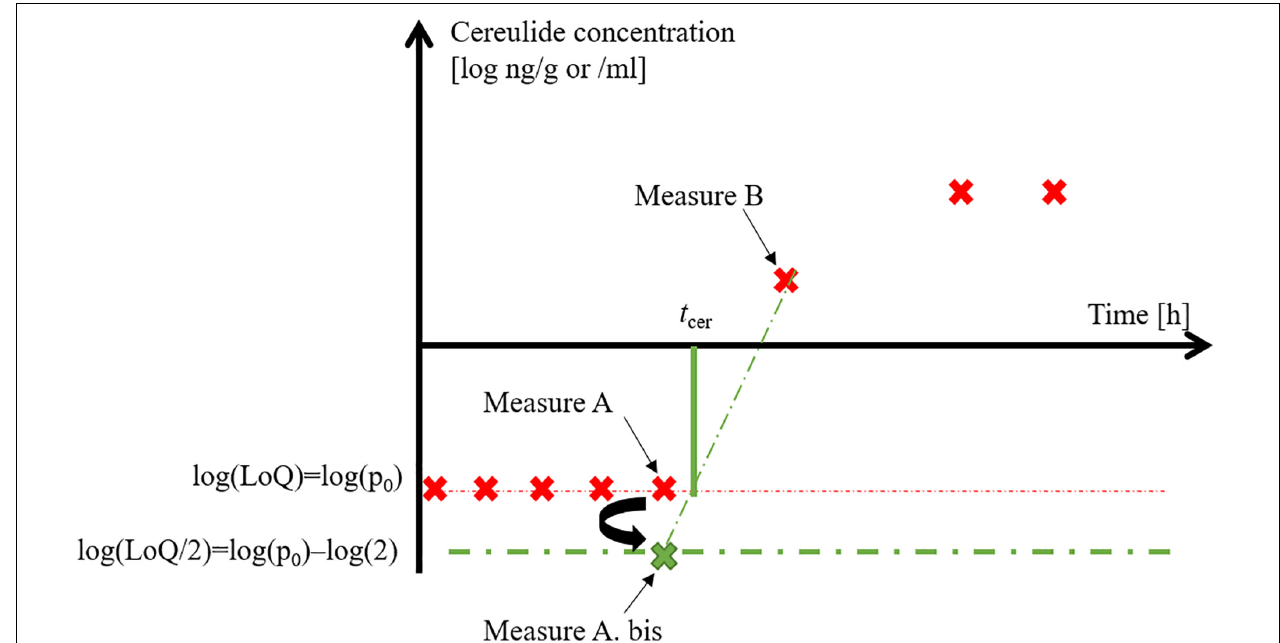
FIGURE 1 | Linear interpolation to calculate t cer , the time to quantifiable cereulide